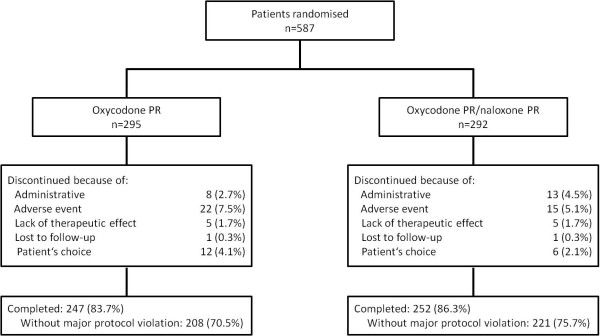
Patient disposition. PR = prolonged-release